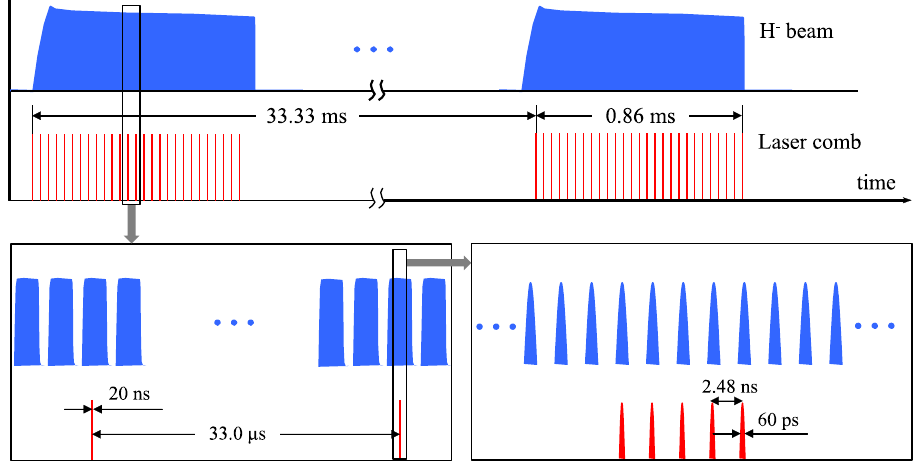
FIG. 3. Temporal structure of the laser comb used for H − beam diagnostics. H − beam waveforms (Fig. 1 is referred to for labels) are plotted as a reference. Top: H − beam macropulse at 60 Hz and laser comb macropulses at 30 Hz in this work. Bottom left: waveforms of H − beam minipulses and laser comb teeth. Bottom right: waveforms of H − beam bunches and micropulses inside a laser comb